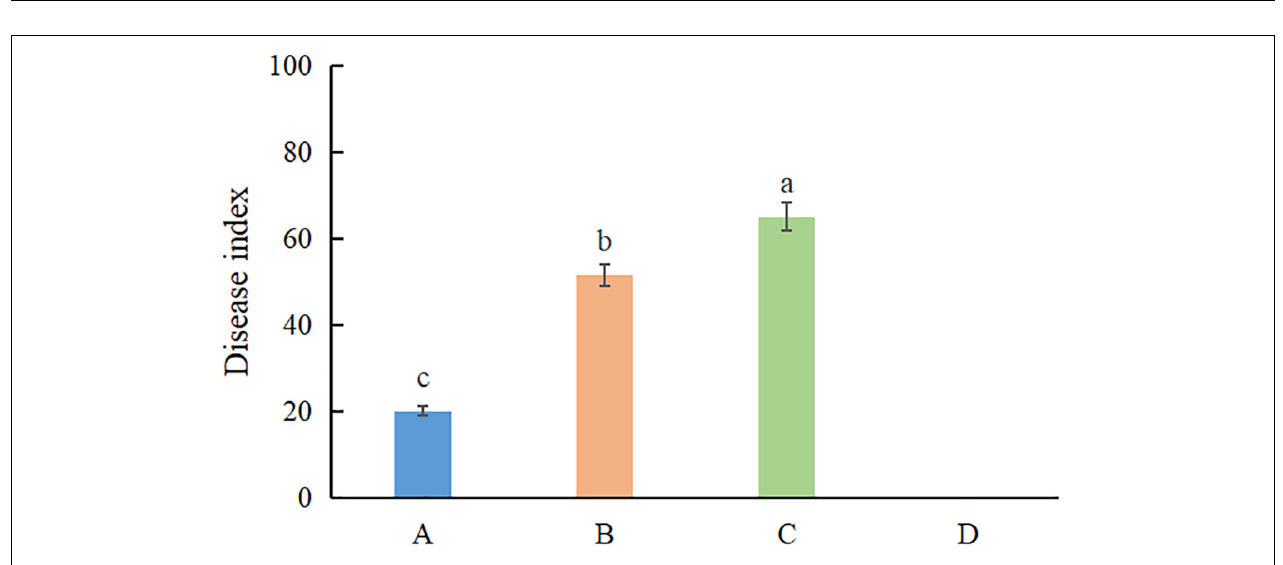
FIGURE 7 | The disease index of inoculation of Fusarium species on Alocasia modestum . A, inoculation with F. elaeidis only. B, inoculation with F. aglaonematis only. C, inoculation with both F. elaeidis and F. aglaonematis . D, control, inoculation with sterilized water. a, b, and c indicate significant differences ( P < 0.05).